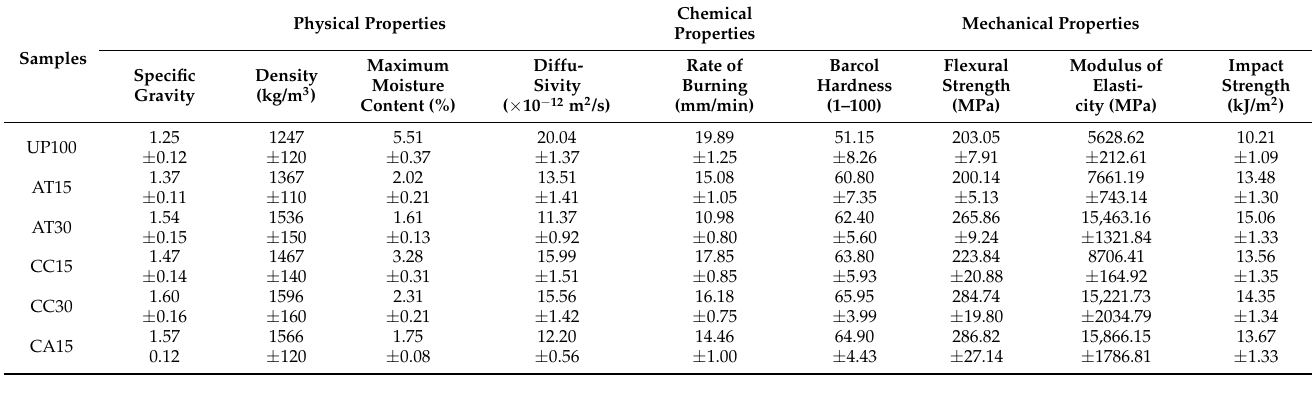
Table 2. Physical, chemical, and mechanical properties of the GFRP samples.